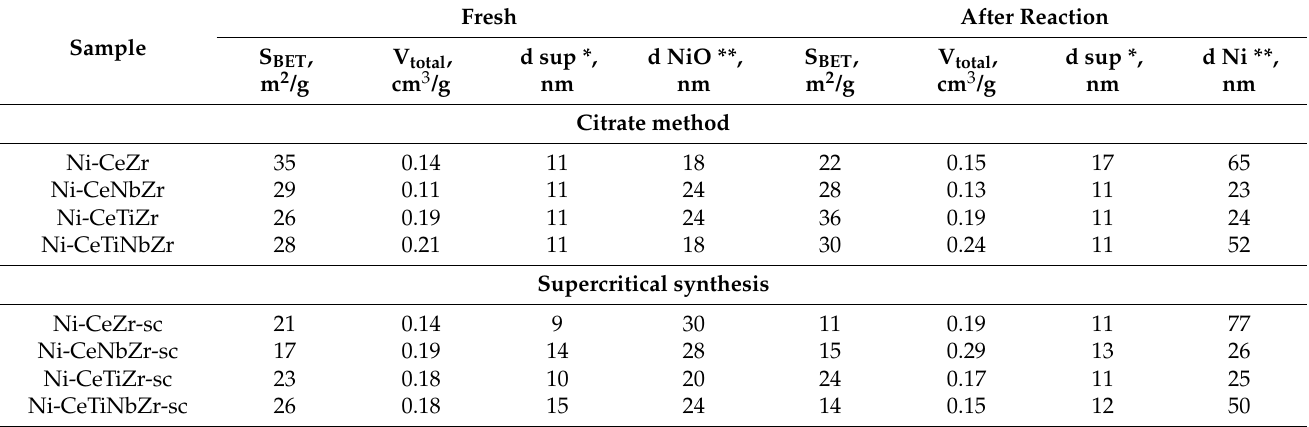
Table 2. Textural and structural properties of fresh and spent